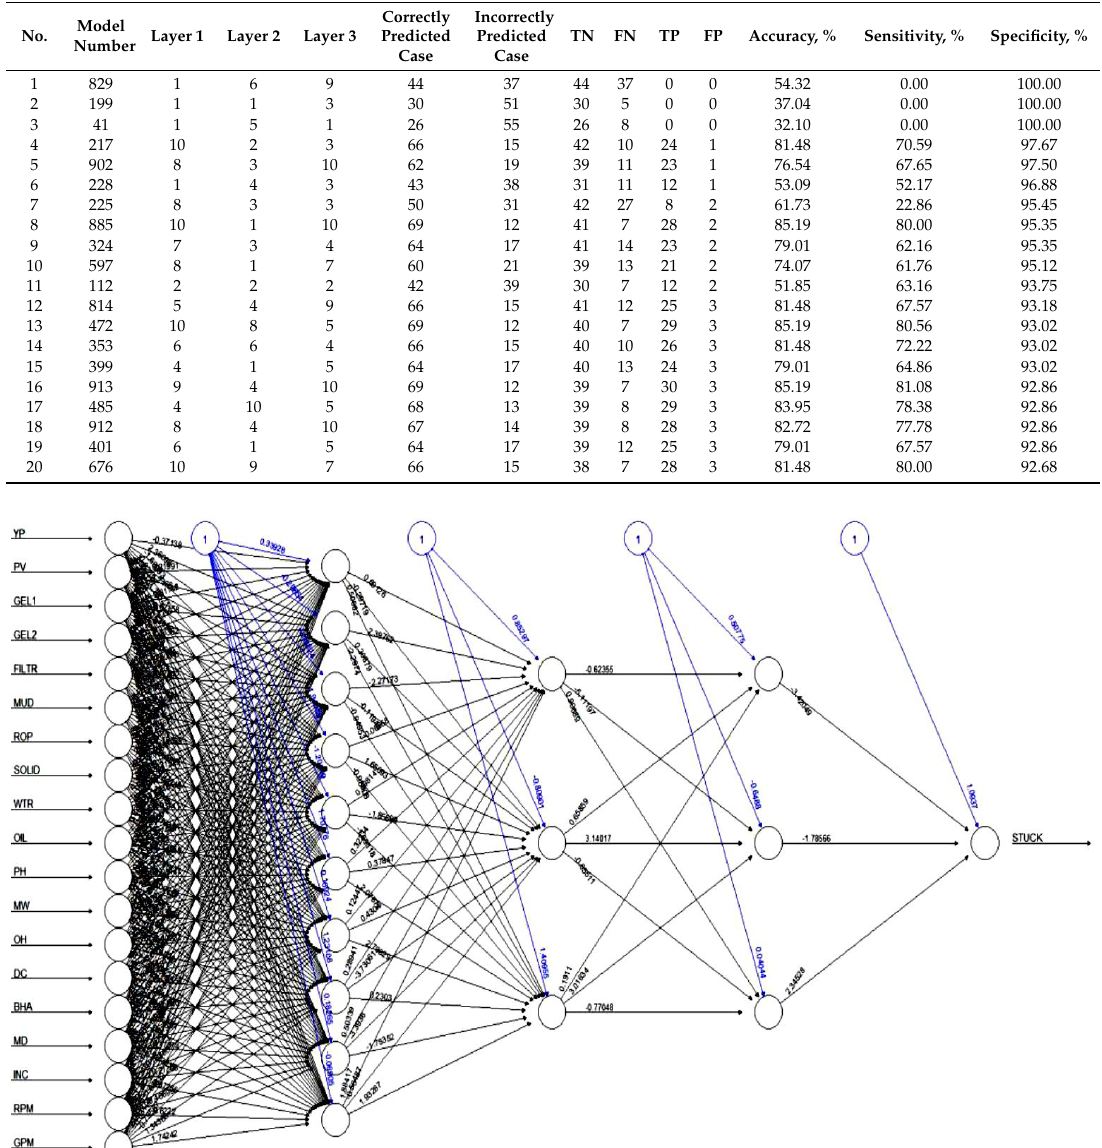
Table 14. Top twenty “Specificity” results for the hyperbolic tangent activation function ANN models. No.